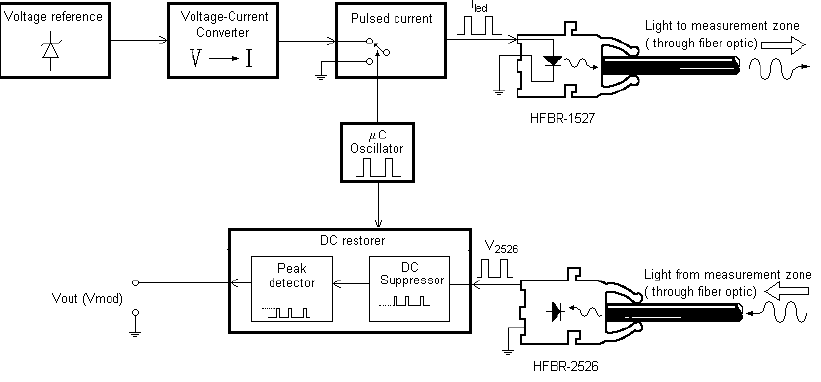
Figure 10. Block Diagram of the system for temperature compensation by means of